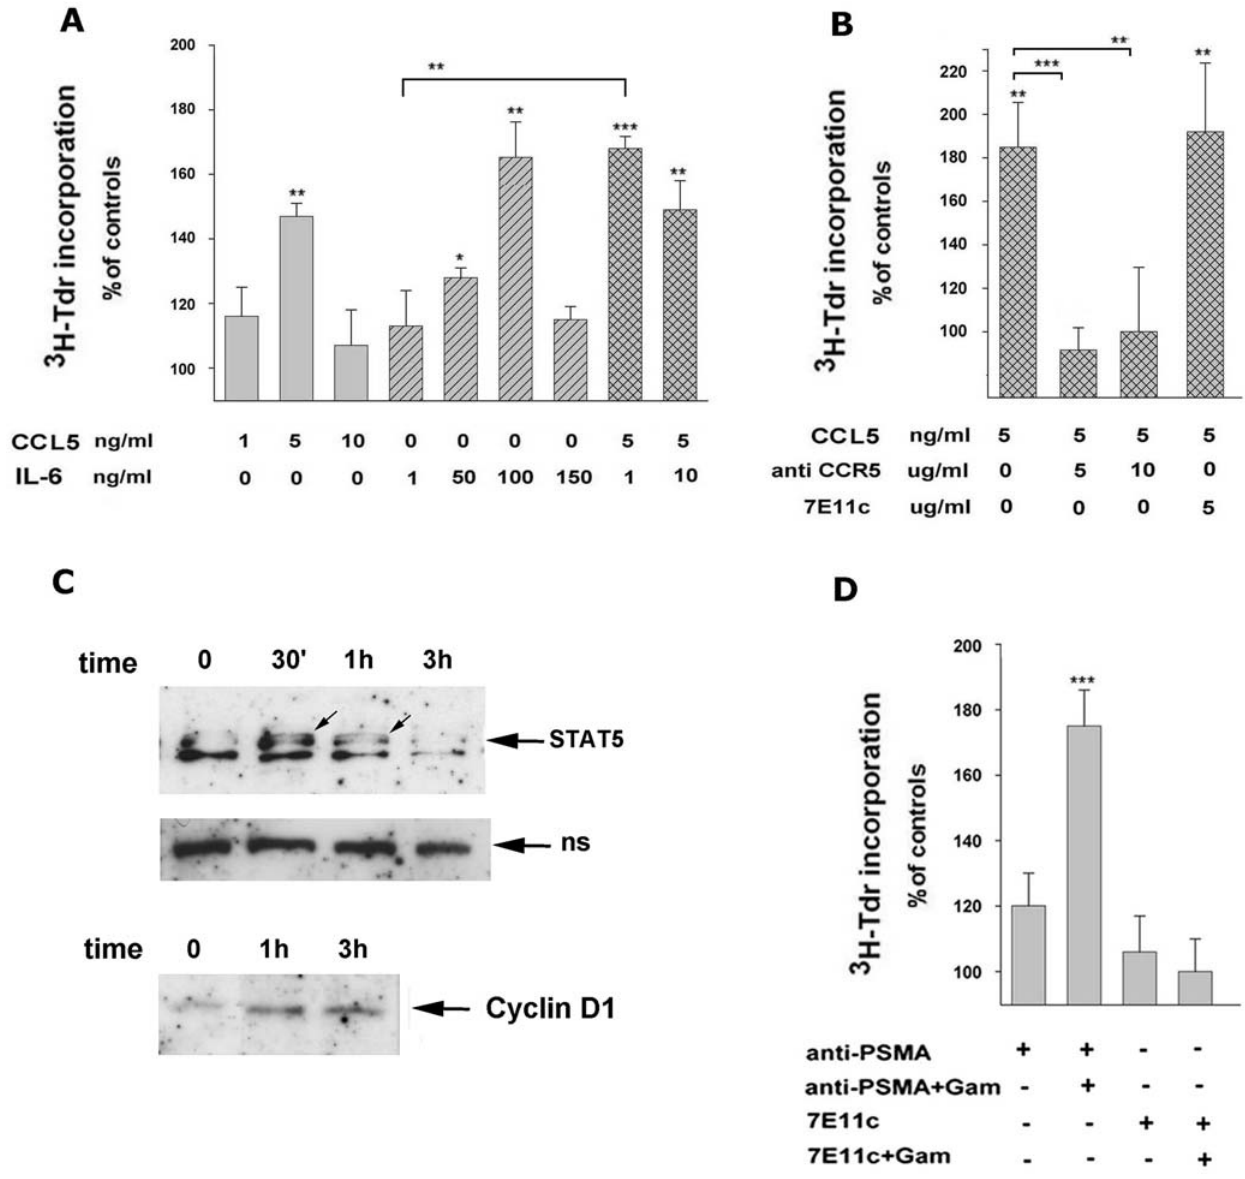
Figure 5. Effects of pro-proliferative stimuli on LNCaP cells. A) LNCaP proliferation induced by treatment with CCL5 and/or IL-6. 3 H-TdR uptake of cells after 24 h of culture with CCL5 (grey bars), 72 h of culture with IL-6 (hatched bars) or 24 h of culture with combinations of CCL5 and IL-6 (crossed bars) at the indicated concentrations. B) 3 H-TdR uptake of cells after 24 h culture with 5 ng/ml of CCL5 in the presence or in the absence of anti-CCR5 or 7E11c antibodies at the indicated concentrations; C) Western blot analysis of cell extracts (20 m g/lane) of LNCaP cells treated with CCL5 (5 ng/ml) and probed with anti-STAT 5 or with anti-cyclin D1 antibodies. Equal protein loading in all the lanes is confirmed by not specific bands shown in the middle gel. Arrows indicate phosphorylated STAT5 proteins. Western blotting results are representative of two independent experiments. D) 3 H-TdR uptake of cells 72 h after binding or cross-linking of 7E11c or anti-PSMA antibodies. Values represent the mean 6 SEM of three independent experiments performed in triplicates. Stars on the bars indicate statistical significance as in Fig.